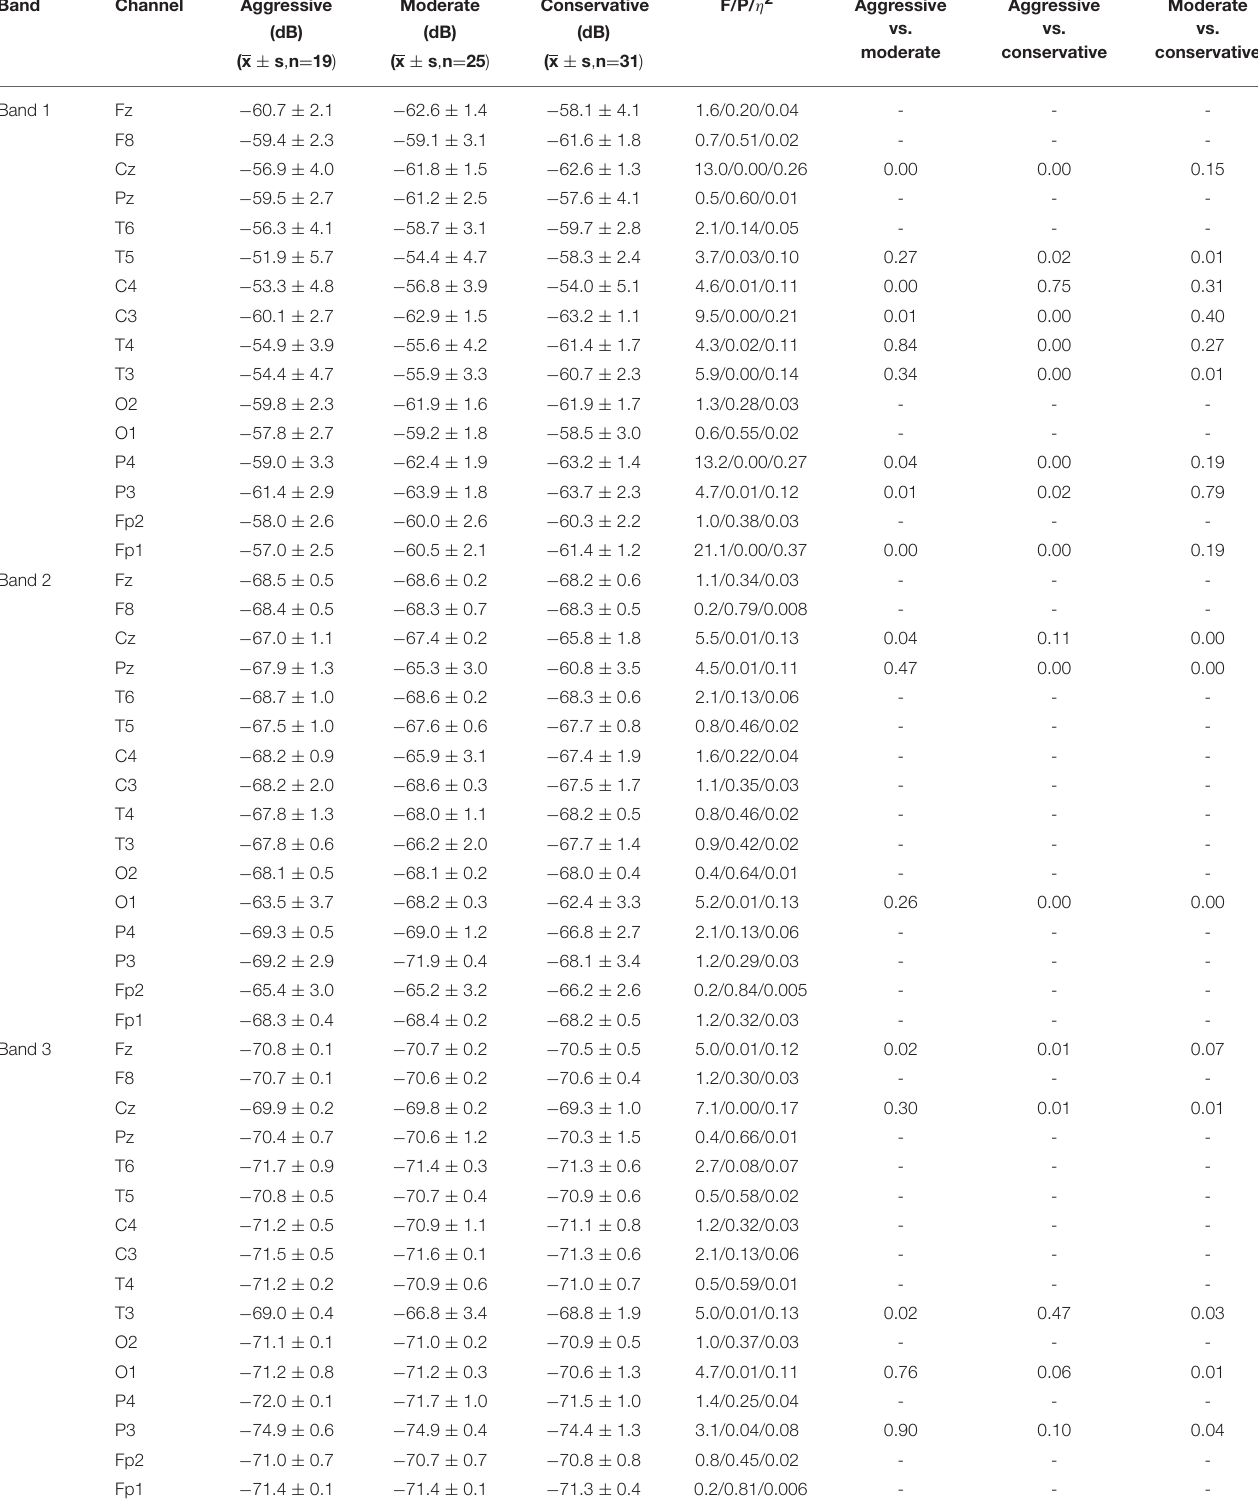
TABLE 2 | Power spectral densities of three groups in three frequency bands. Band Channel Aggressive Moderate Conservative F/P/ η 2 Aggressive